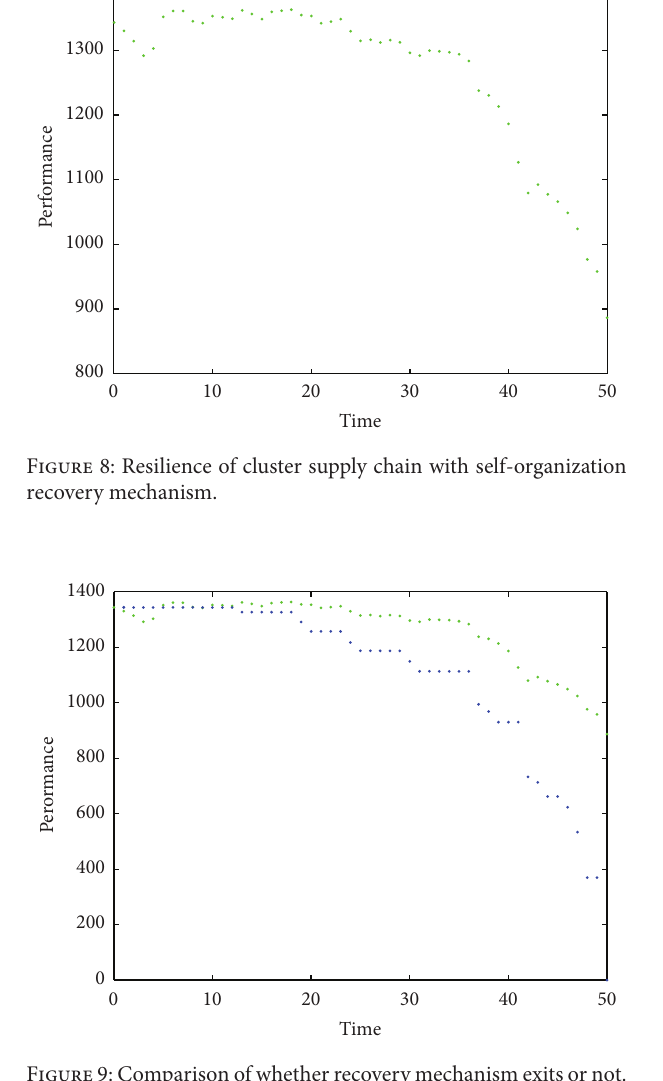
Figure 9: Comparison of whether recovery mechanism exits or